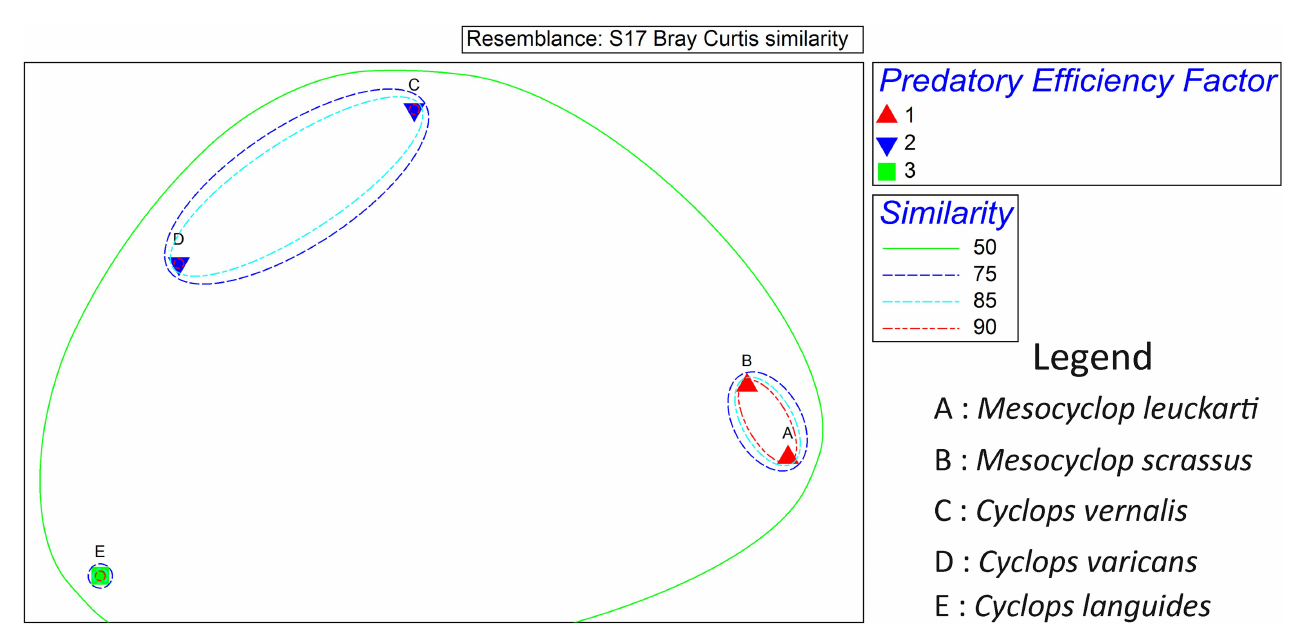
Fig 5. Multidimensional scaling (MDS) plot for the copepods based on predatory efficiency on Aedes larvae.